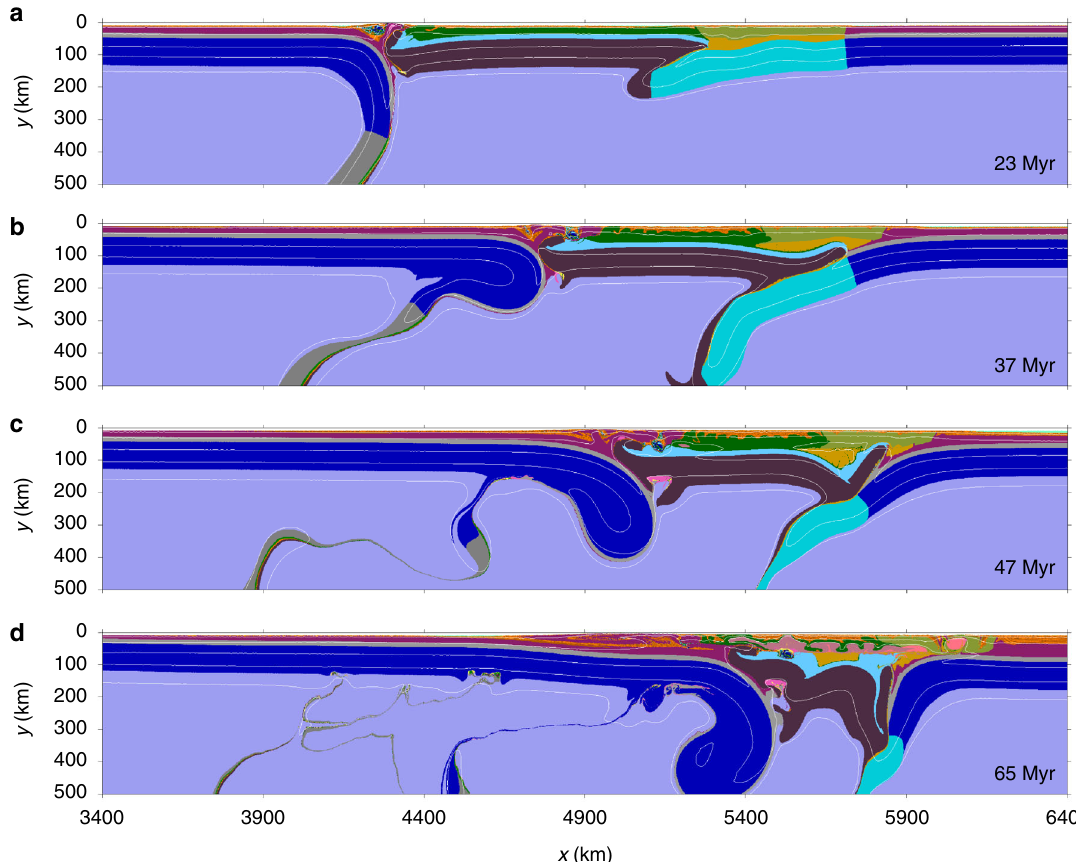
Fig. 4 Evolution of partial terrane detachment mode (Mode-II). The widths of the strong and weak terranes are 1200 and 700 km, respectively. The reference density of the lithospheric mantle of both the strong and weak terranes is the same as the asthenosphere. Time of convergence is shown in each panel. Colors of rock types are as in Fig. 2a. White numbered lines are isotherms plotted every 300 °C starting from 100